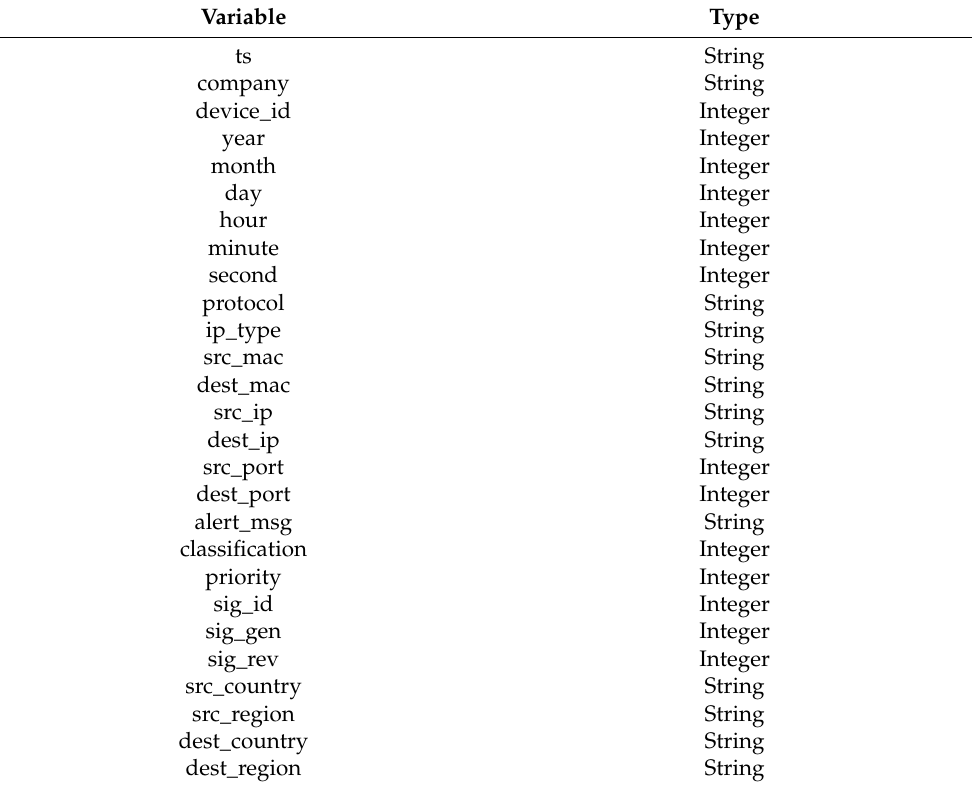
Table 5. The aggregated data after the processing of the data